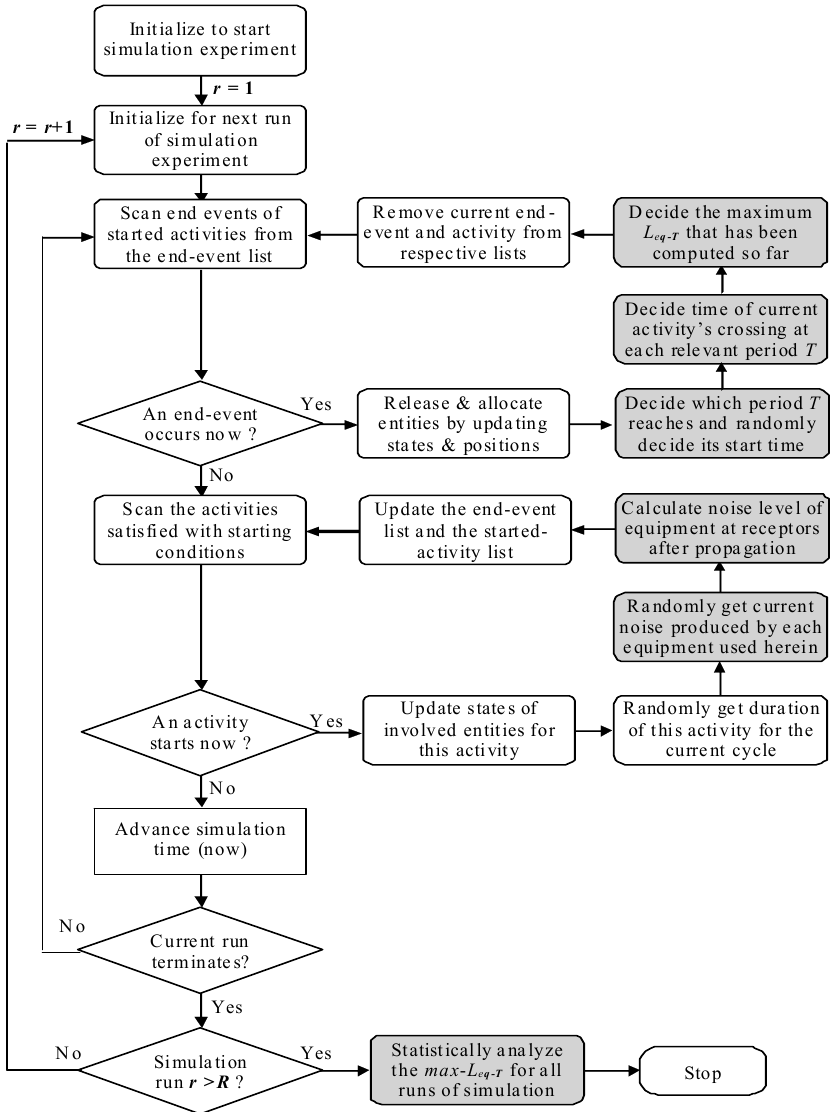
Figure 3. Flowchart of the simulation strategy incorporated with the noise-calculating models.